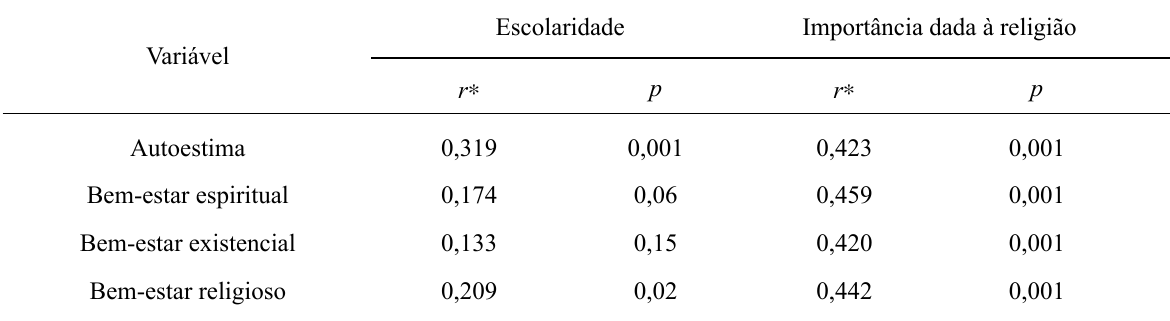
Correlação da Escolaridade e Importância dada a Religião com Autoestima e Bem Estar Espiritual, Alfenas, Minas Gerais, 2013 (N=118)